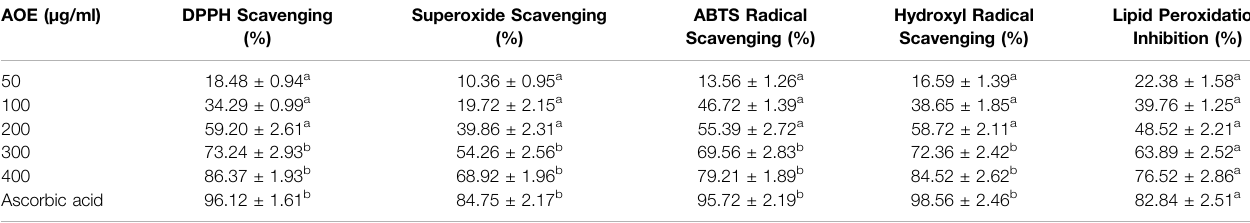
TABLE 3 | DPPH, ABTS, superoxide, hydroxyl radical scavenging, and lipid peroxidation inhibition potential of AOE and ascorbic acid. AOE (µg/ml) DPPH Scavenging